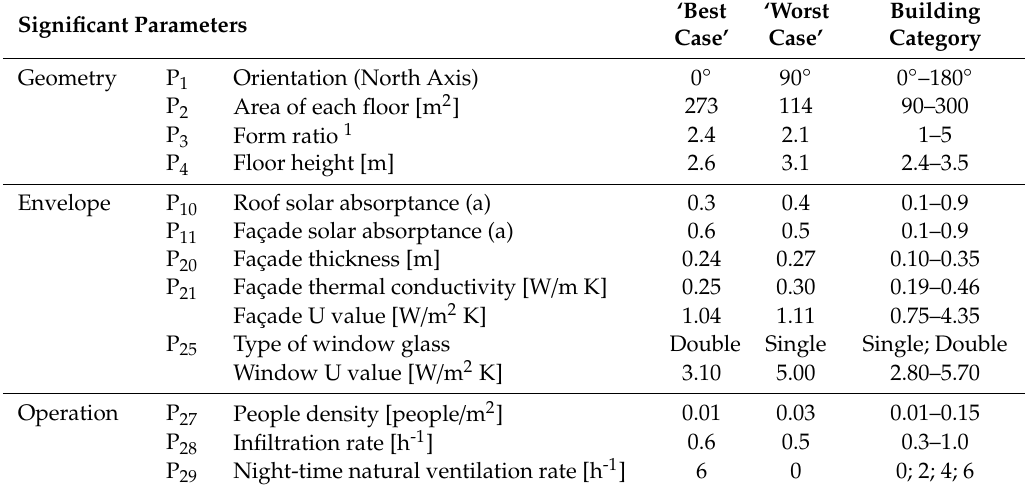
Table 5. Characterization of the ‘best’ and ‘worst’ case within the building category.